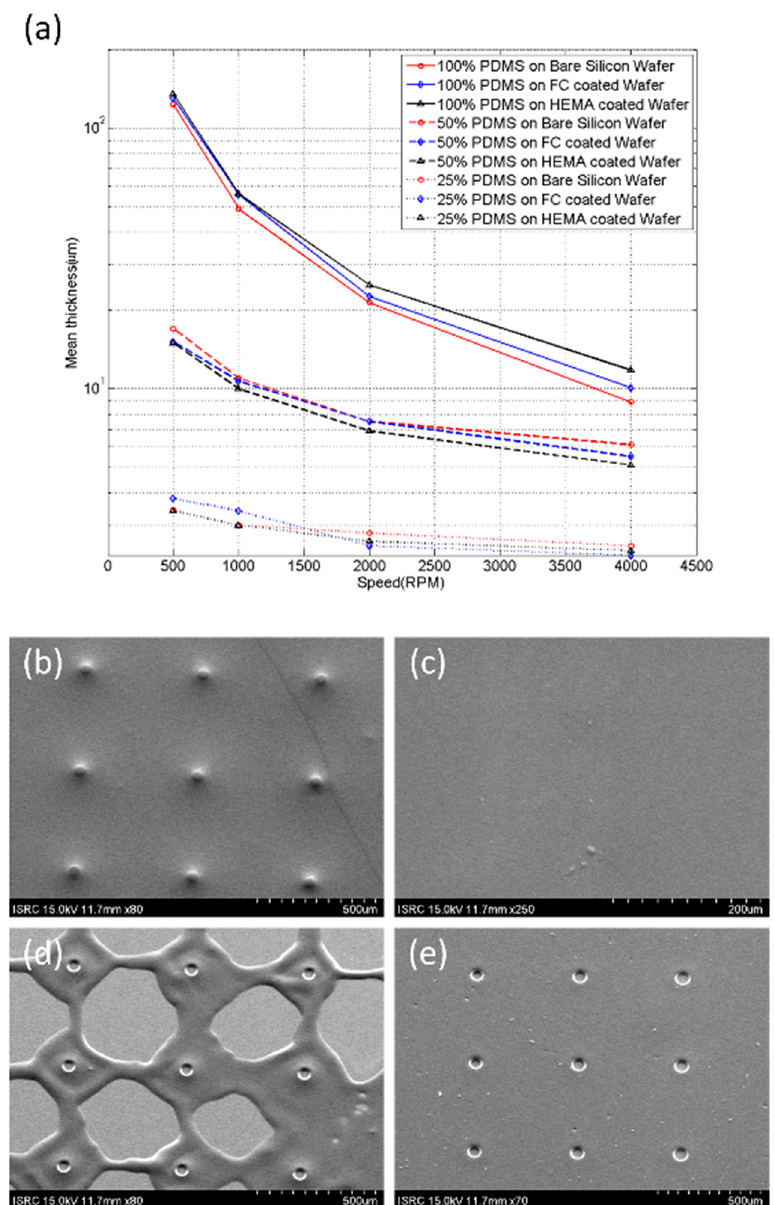
Figure 5. Characterization of PDMS spin-coating. ( a ) The thickness of PDMS film depended on spin-coating speed. The spin-coating speeds were 500, 1000, 2000, and 4000 rpm for 60 s. Each point on the plot corresponds to measurements on 25 samples from 5 rounds of fabrication. ( b – e ) SEM images measuring the uniformity of the PDMS film. ( b ) Uncured PDMS spin-coated with a thickness of 10 μ m on a photoresist post with a height of 20 μ m. ( c ) Uncured PDMS spin-coated with a thickness of 40 μ m on a photoresist post with a height of 20 μ m. The photoresist posts are not revealed on the surface due to the thick PDMS film. ( d ) Cured PDMS of ( b ) etched by 9% TBAF solution for 4 min. The PDMS in the nearby and far posts were thick and thin, respectively. Hence, we could not obtain a uniform PDMS film. ( e ) Cured PDMS of ( b ) etched by 9% TBAF solution for 10 min. Uniform PDMS film with holes could be obtained.